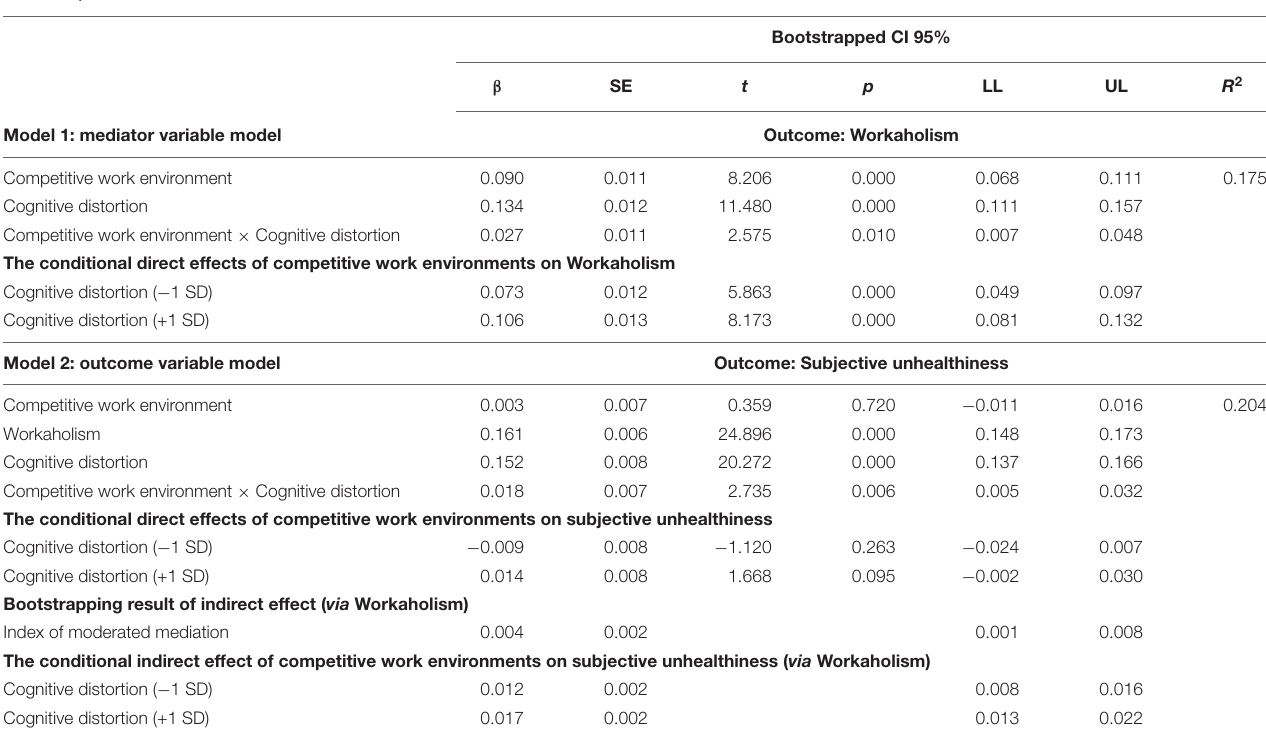
TABLE 3 | The result of the moderated mediation